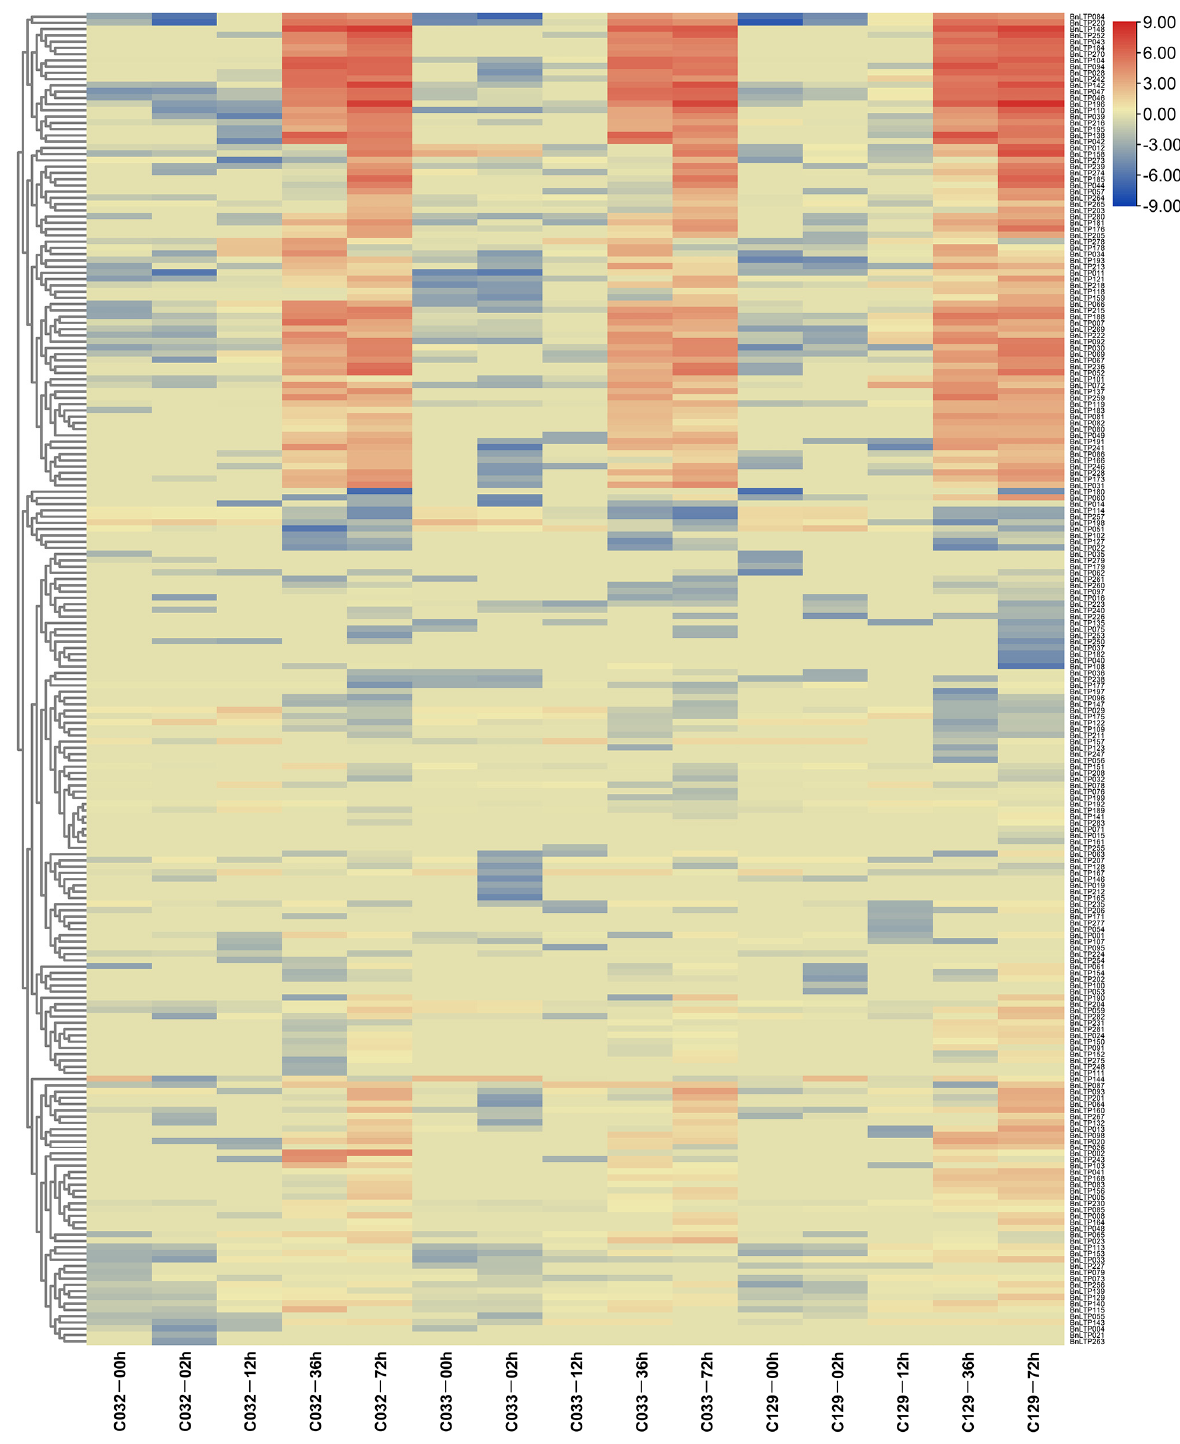
Figure 8. The heatmap of the expression levels of BnLTP genes at different germination stages of B. napus accessions seeds with representative germination rates (high, medium, or low; C129, C033 and C032, respectively) at 0, 12, 24, 48 and 72 h after imbibition. 2.12. Expression of nsLTPs in B. napus Brown Seeds and Yellow Mutation Of the 55,637 unigenes identified in 26 d brown seeds and yellow mutation, 64 BnLTP genes were detected (Table S22). Only three BnLTP genes, BnLTP089 , BnLTP110 and BnLTP257 were found to be DEGs between the materials, which were all up-regulated in